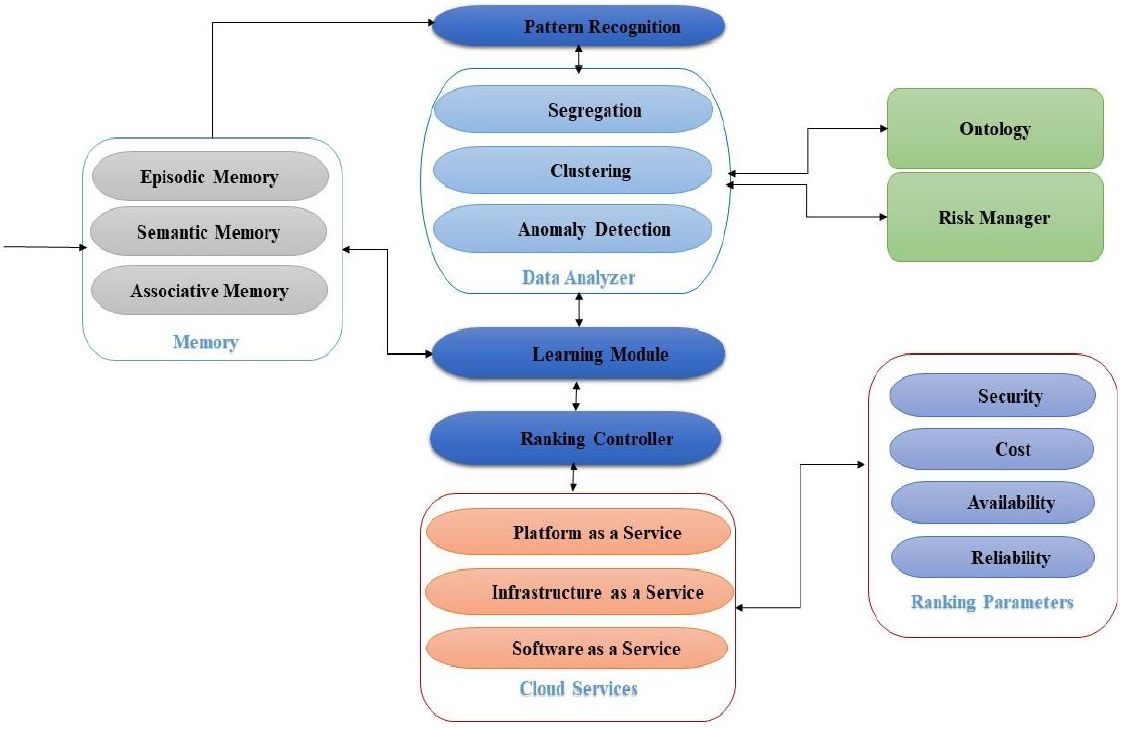
Figure 5. InteliRank: Cloud-service ranking agent.